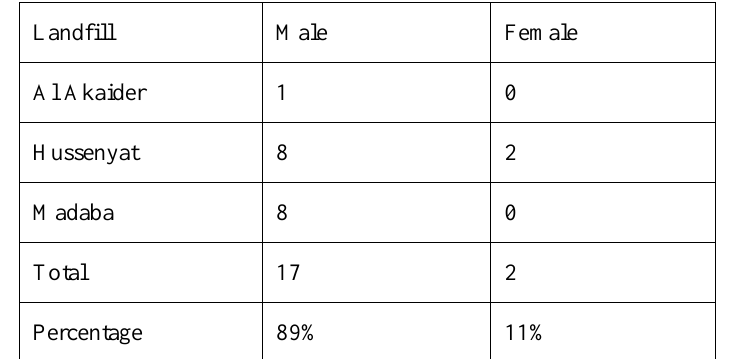
Table 3. Genders of waste